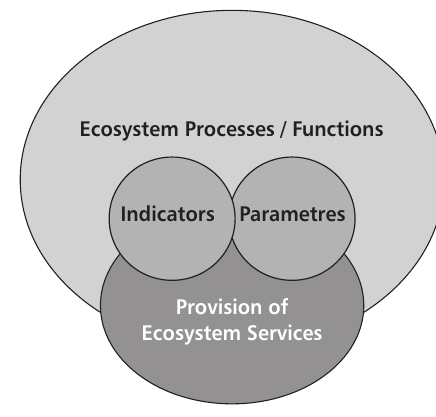
Linking ecosystem functions or processes and provision of ecosystem services to indicators and parameters Political relevance, analytical soundness and